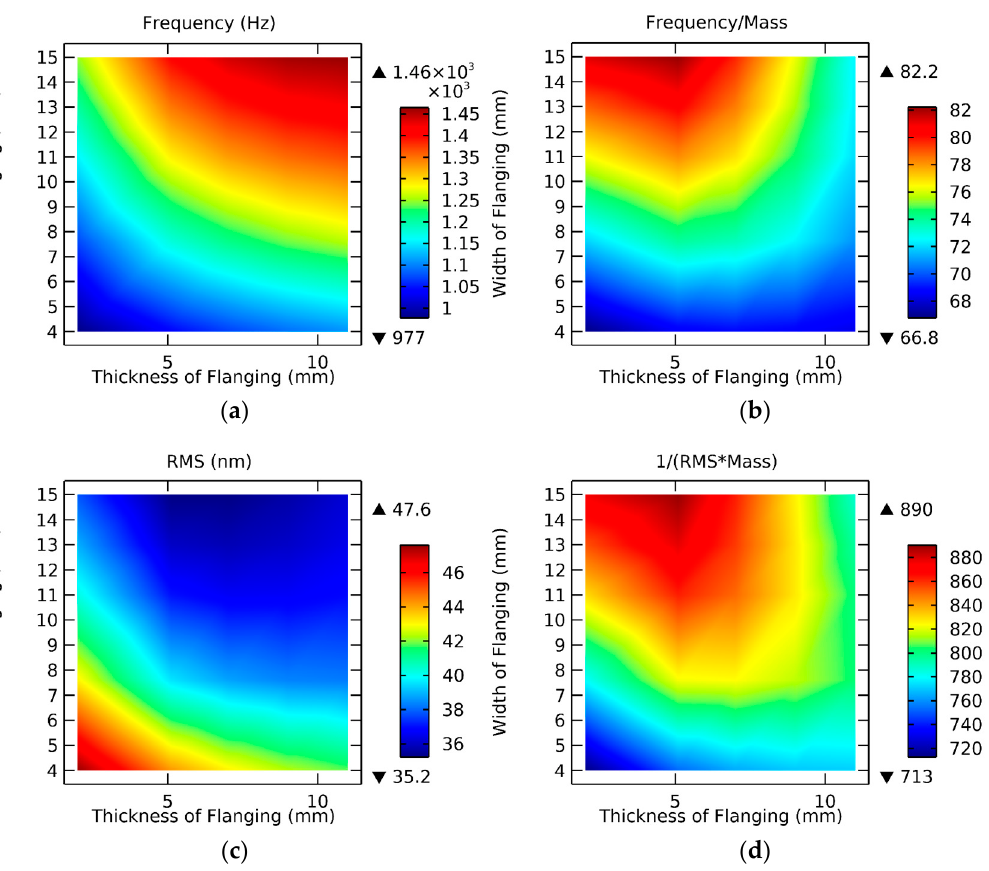
Figure 5. Performance analysis of flanging’s thickness and width under different parameters. ( a ) Frequency; ( b ) Frequency/Mass; ( c ) RMS; ( d ) 1/(RMS*Mass). quency; ( b ) Frequency/Mass; ( c ) RMS; ( d )